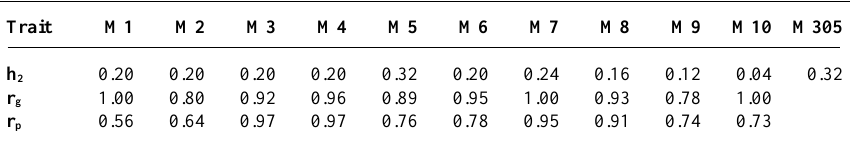
Table III - Heritability estimates (h 2 ) of test day milk yields (M1 to M10), and genetic (r g ) and phenotypic